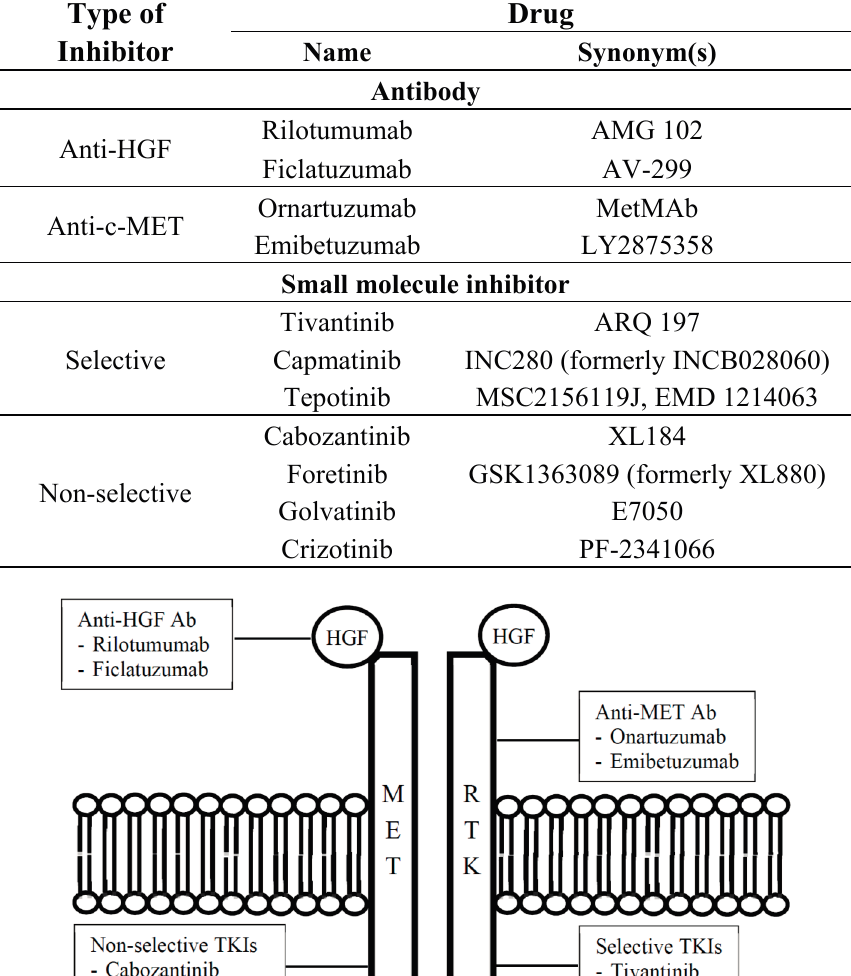
Table 1. Classification of HGF/c-MET Inhibitors.